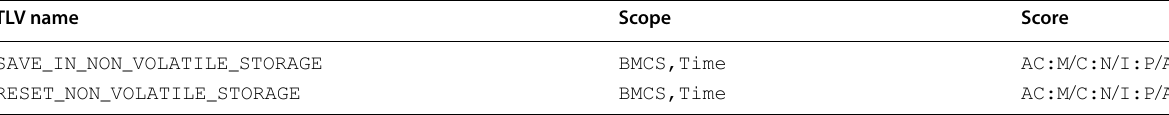
Table 4 PTP IEEE-1588 2008 TLVs that can be used to tamper the network